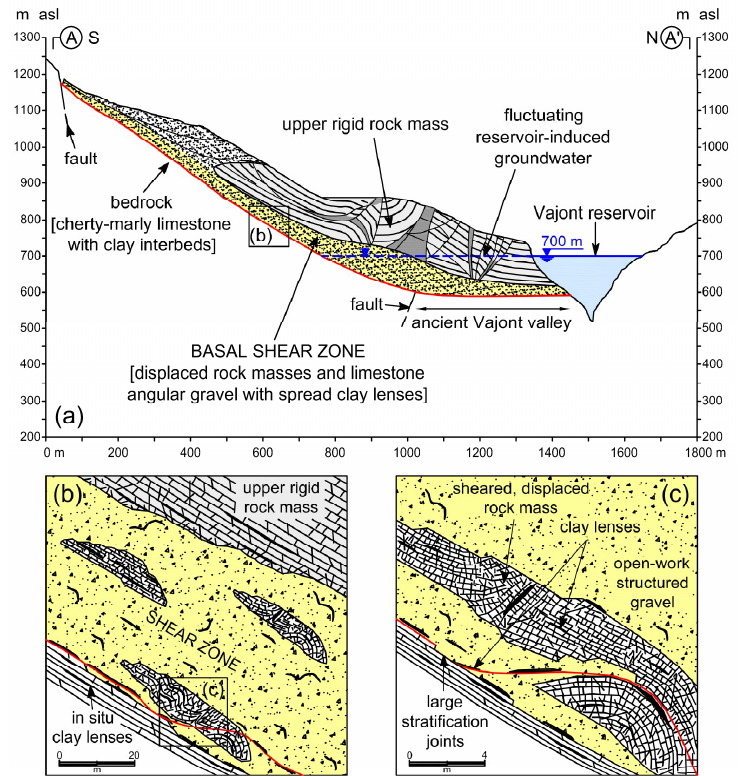
Figure 3. ( a ) Geological cross-section of the Vajont slide before 9 October 1963 displaying the thick shear zone interposed between the upper rock mass and the underlying bedrock. ( b )–( c ) The failure surface involved different materials within the basal shear zone (modified figure from [24]).